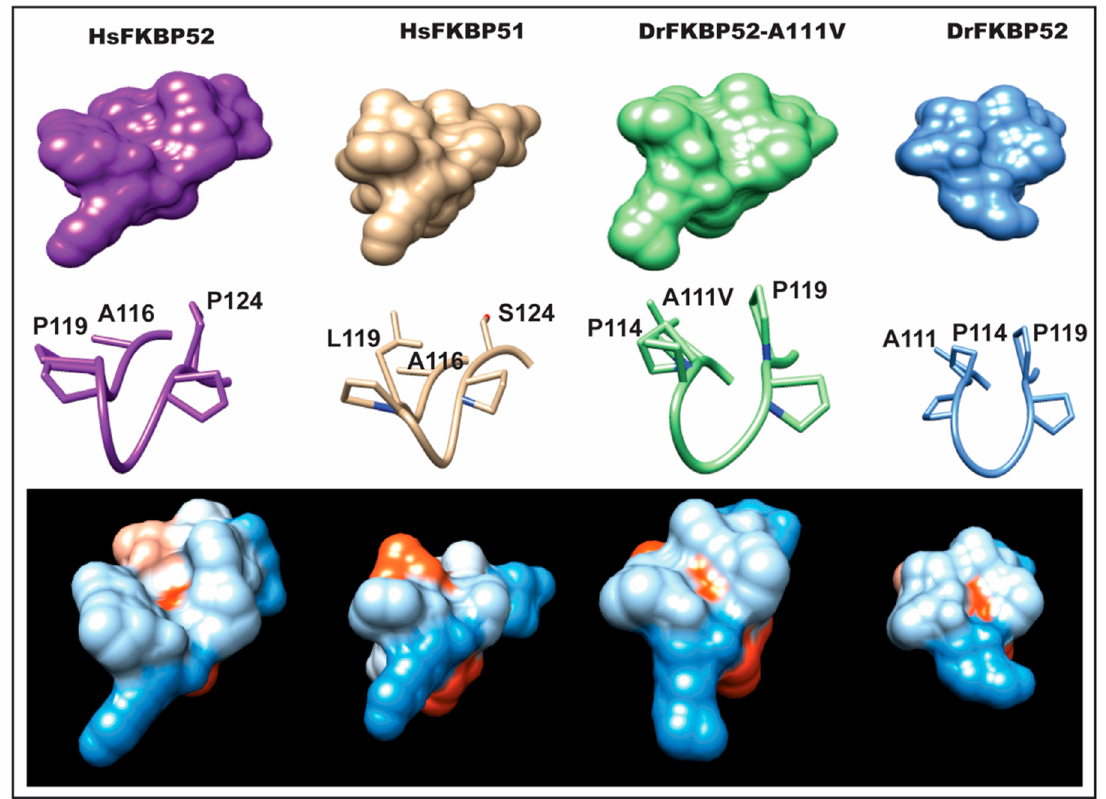
Figure 6. Predicted structural di ff erences in the FK1 proline-rich loop. Homology modeling was used to generate predicted models of DrFKBP52 and DrFKBP52-A111V, in the comparison to human FKBP52 and FKBP51 to determine conformational changes induced by the DrFKBP52-A111V mutation. Crystal structures of HsFKBP51 (PDB ID: 1KT0), HsFKBP52 (PDB ID: 1Q1C), DrFKBP52 (predicted), and DrFKBP52-A111V (predicted) are aligned; the respective FK1 domains are shown in space-filled modeling and colored in hydrophobicity scale (blue = hydrophilic, red = hydrophobic). Note that the only di ff erences between FKBP51 and HsFKBP52 within the loop region are at positions 119 and 124.